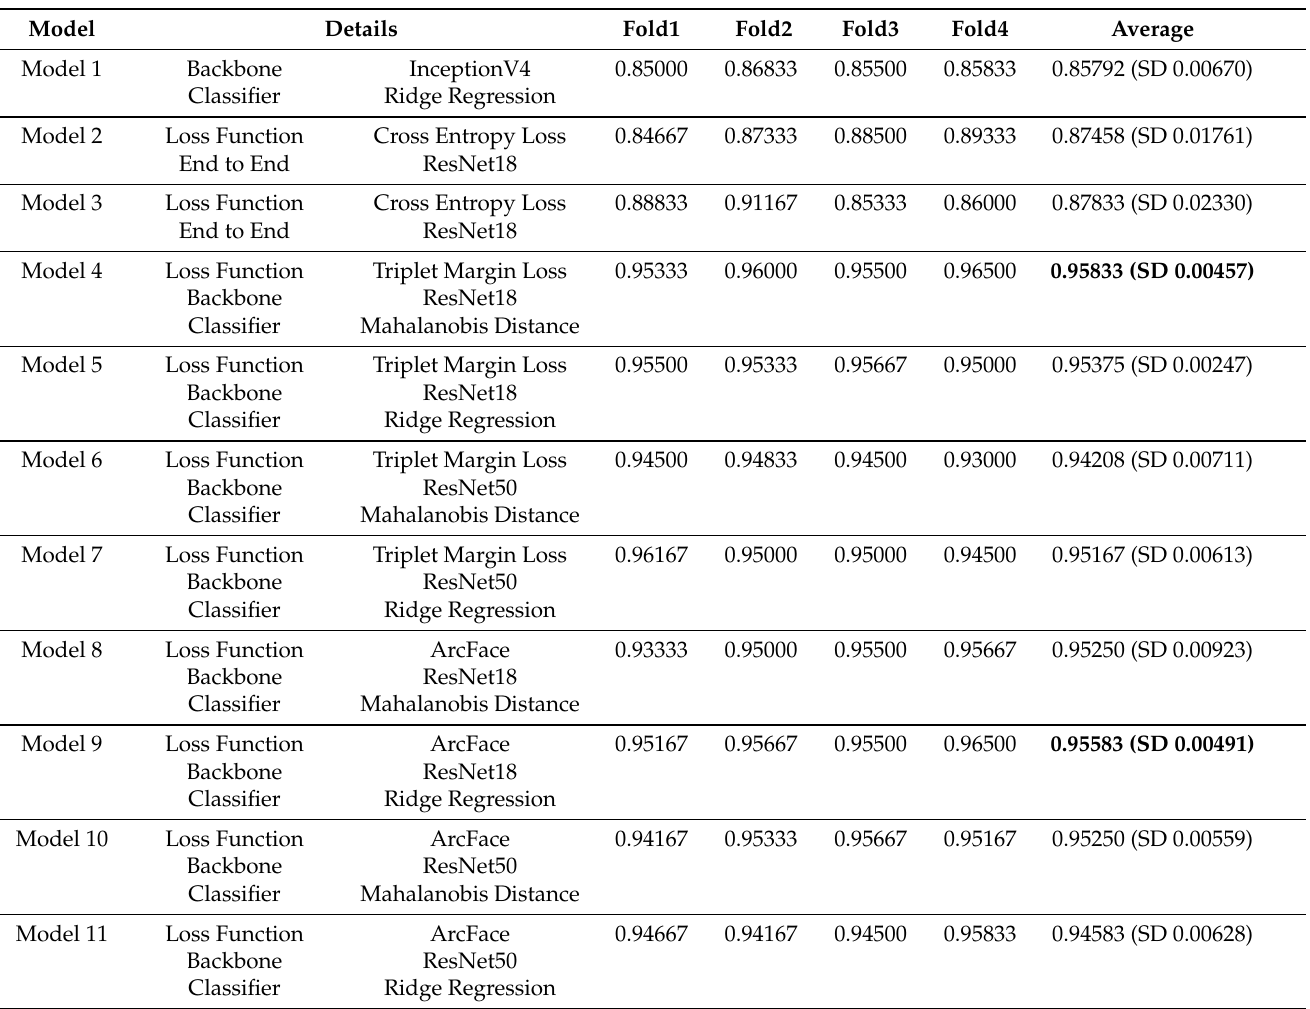
Table 3. Classification results for the six classifications. Model 1 through Model 3 are prior studies, and Model 4 through Model 11 are proposed methods using deep metric learning. The details column provides details of the model. “Backbone” describes the main CNN model, and “Classifier” describes the classification method. In particular, Model 2 and Model 3 are described as “End to End" because feature extraction and classification are performed in one step.